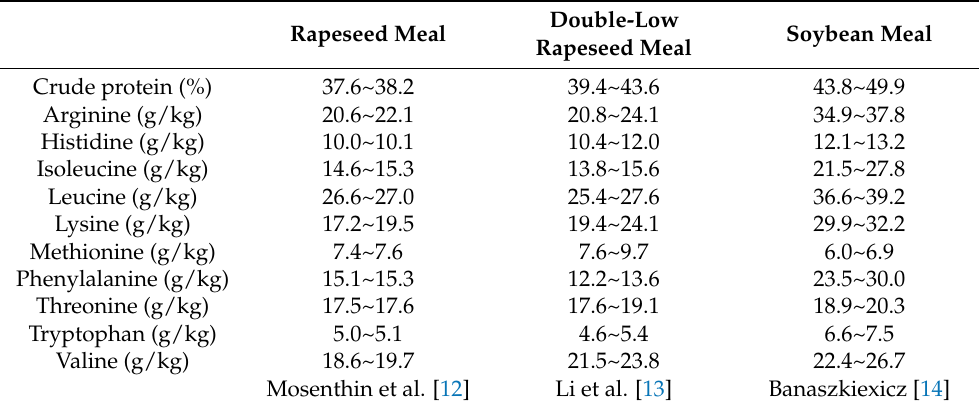
Table 1. Composition of crude protein and essential amino acids of rapeseed meal and soybean meal (as fed basis).